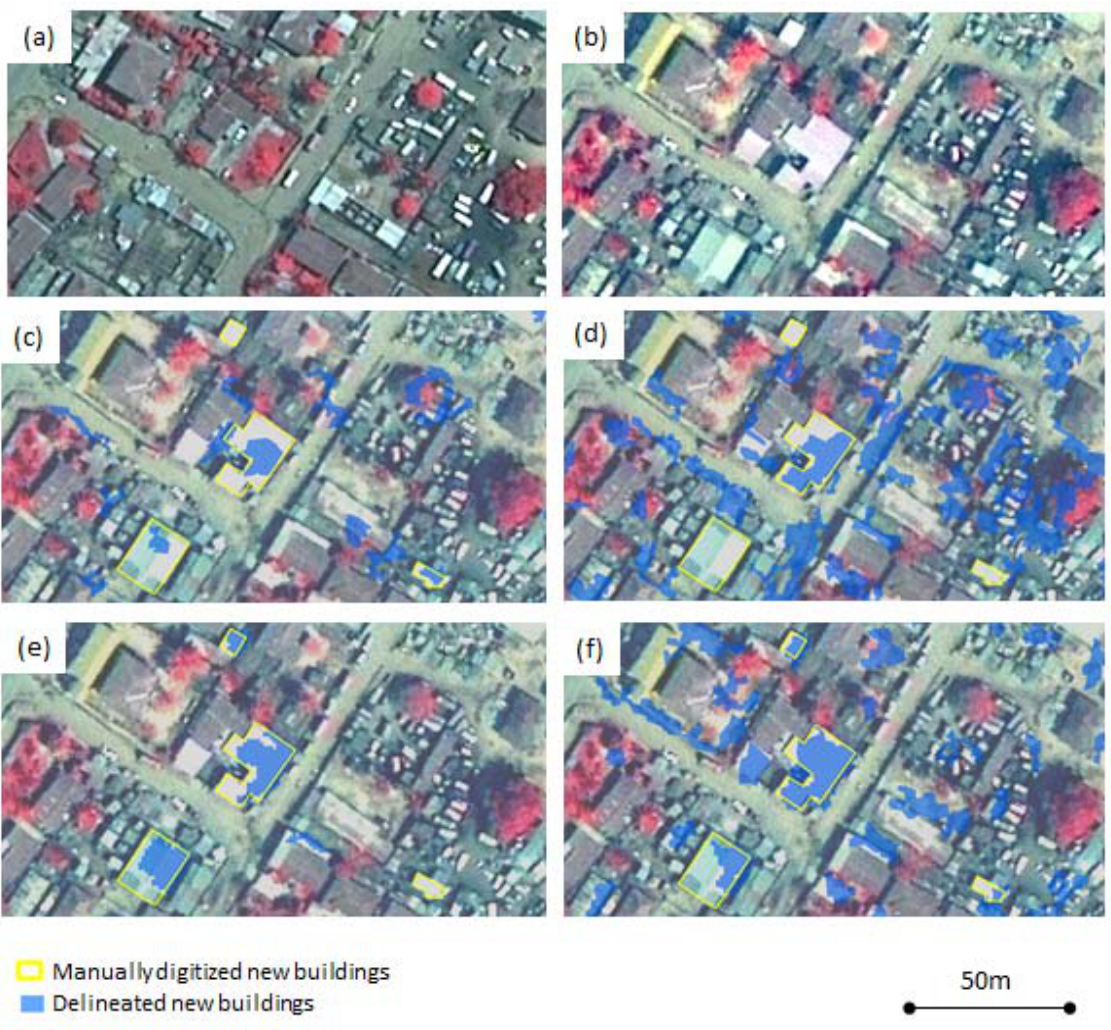
Figure 3. A subset of delineated new results. (a) 2002 pan-sharpened multispectral (PSMS) image subset. (b) 2010 PSMS image subset. (c) Post-classification comparison method using Feature Analyst had a few misclassified objects. (d) Post-classification comparison method using ENVI Feature Extraction had many misclassified errors. (e) Bi-temporal layerstack method using Feature Analyst had little noise. (f) Bi-temporal layerstack method using ENVI Feature Extraction had many false